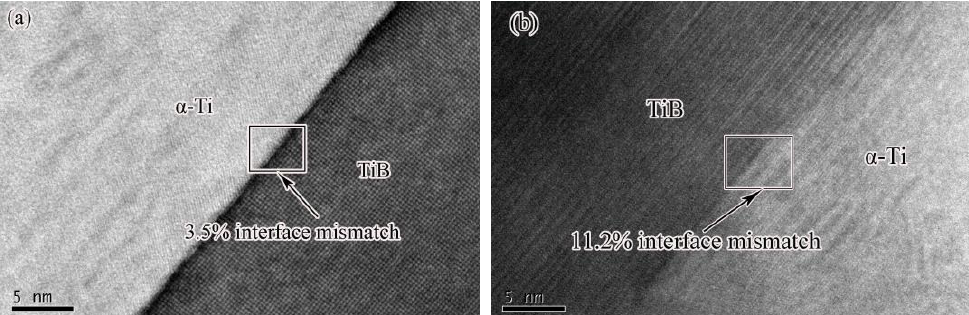
Figure 8. The interfacial mismatch degree of two morphologies of TiB and α-Ti: ( a ) the interfacial mismatch degree of fine needle-like TiB and α-Ti, 3.5%; ( b ) the interfacial mismatch degree for granular TiB and α-Ti, 11.2%.